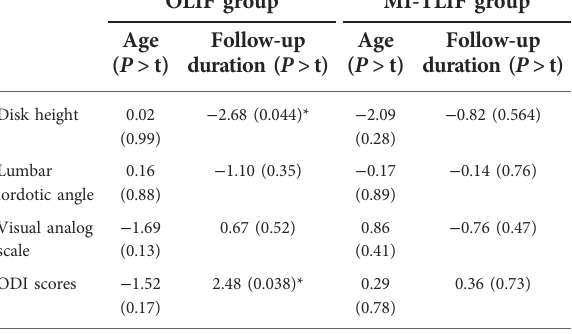
TABLE 5 Meta-Regression analysis on follow-Up and mean age. OLIF